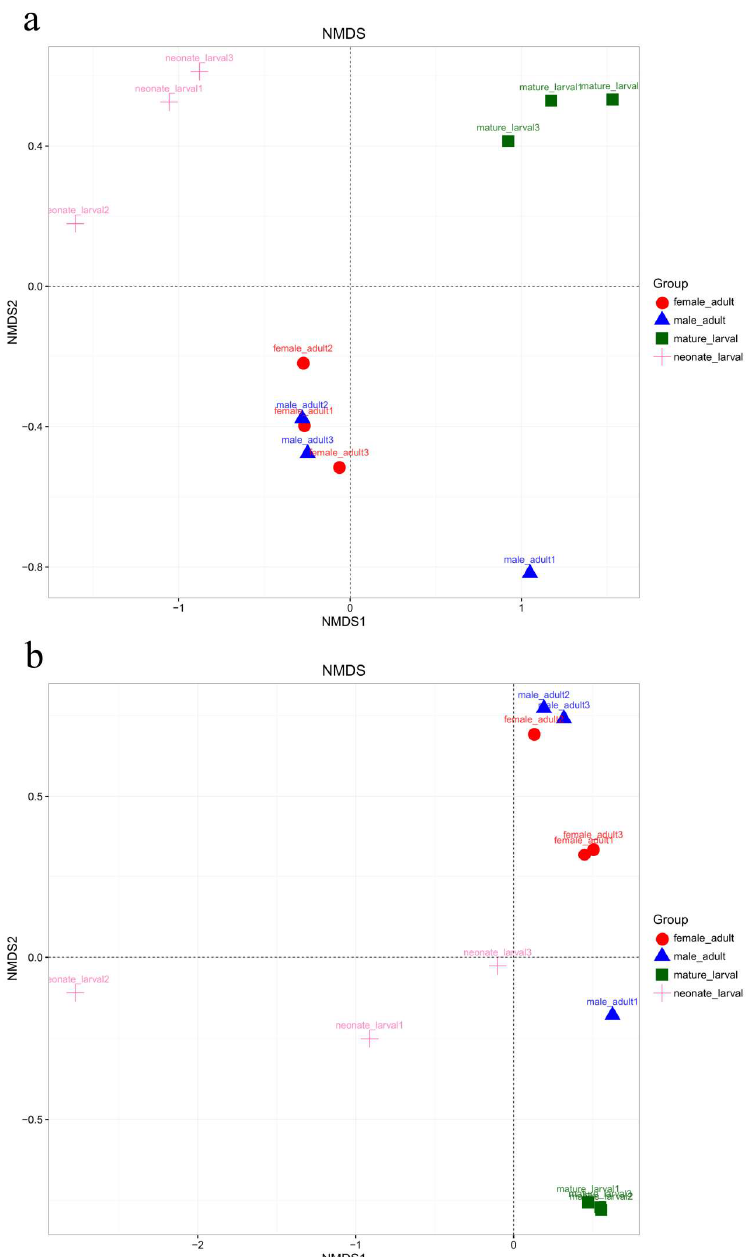
Figure 4. Nonmetric multidimensional scaling analysis of the Bray–Curtis dissimilarity index of the fungal community OTUs ( ≥ 97% identity) in different development stages of T. klimeschi based on Illumina sequencing of ITS genes. ( a ) Unweighted; ( b ) Weighted.